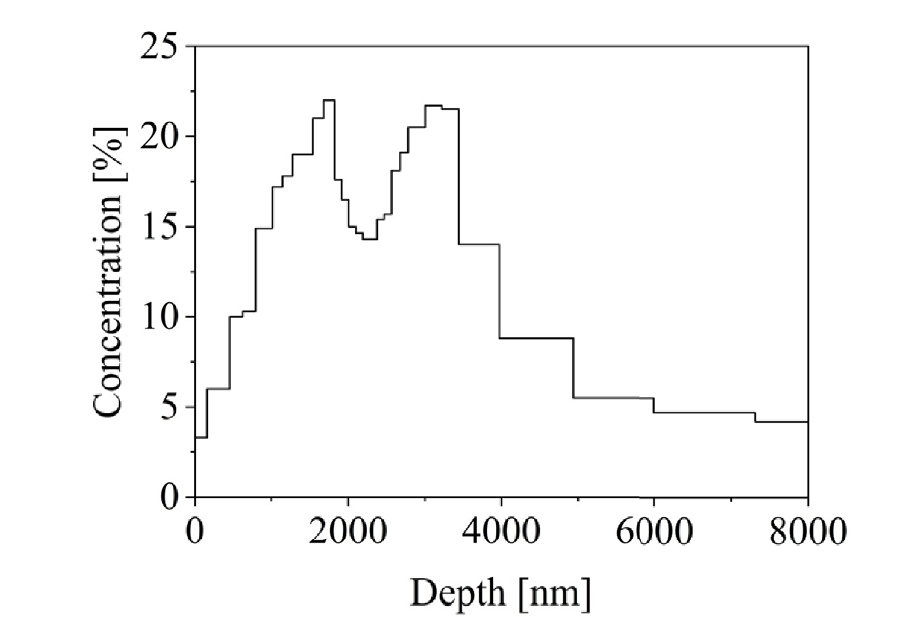
Fig. 1. Deuterium concentration relative to titanium as a function of the depth in titanium. The two peaks show the maxima of previous radiation damage. The range of 3.5 keV deuterium ions in titanium is 41 nm [13].